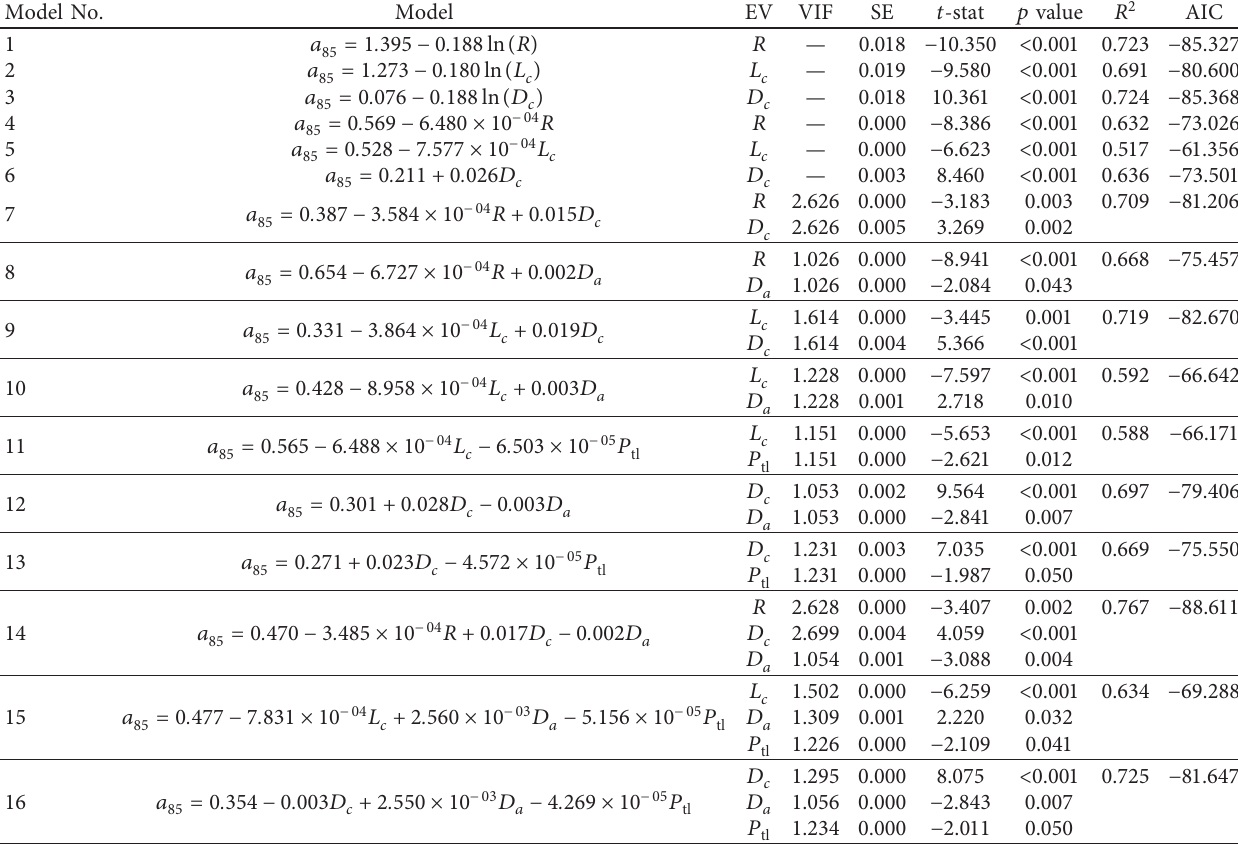
Table 12: Summary statistics of 85 th percentile acceleration rate models. Model